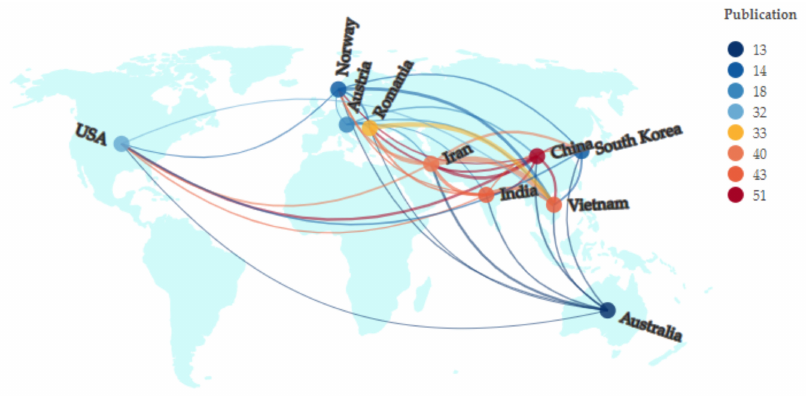
Figure 4. Distribution diagram of number of publication of